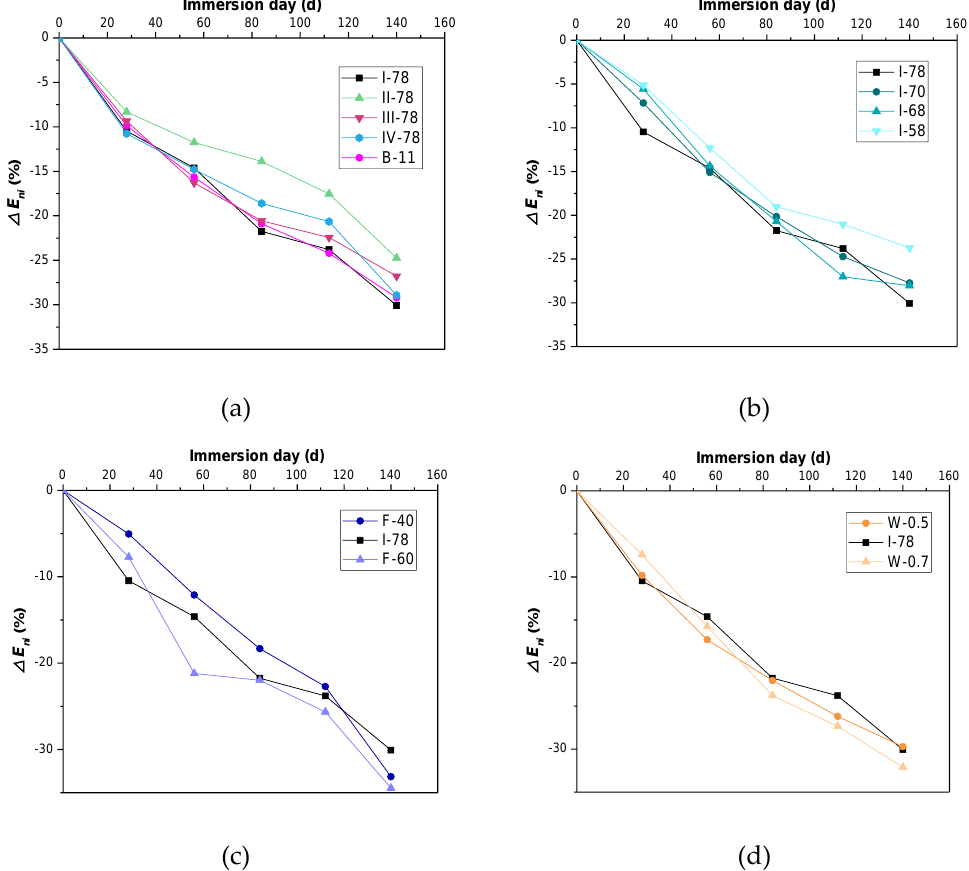
Figure 7. Modulus loss rate of different FGM specimens in acid circumstance. ( a ) Coal gangue types and binder volume effect; ( b ) Aggregate gradation effect; ( c ) Fly ash proportion effect; ( d ) Water to binder ratio effect.